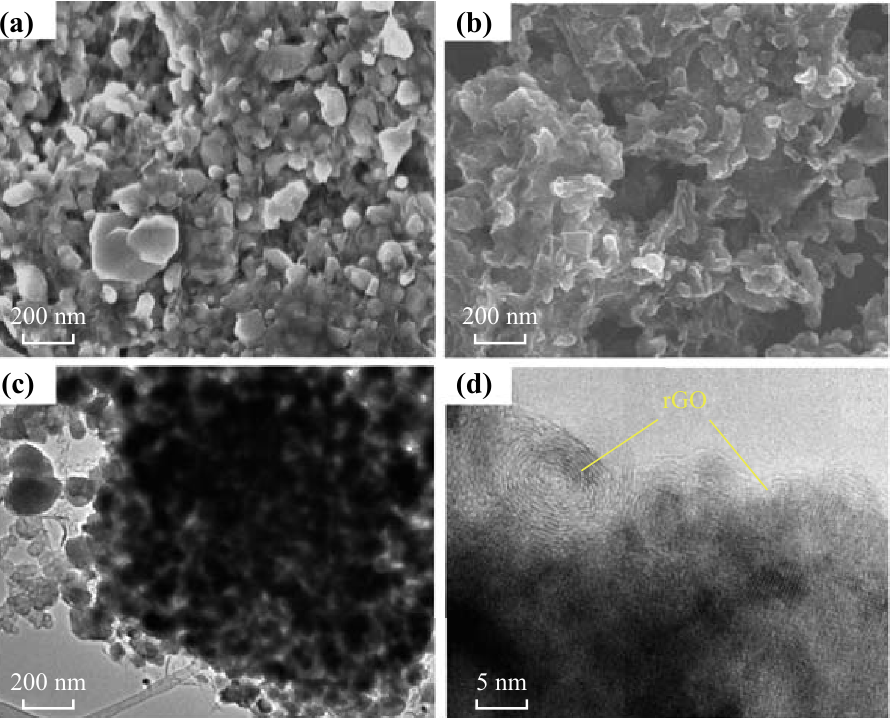
Fig. 6 a SEM image of freshly prepared FeS 2 /rGO electrode, b SEM image, and c , d TEM images of FeS 2 /rGO electrode after 100 charge– discharge